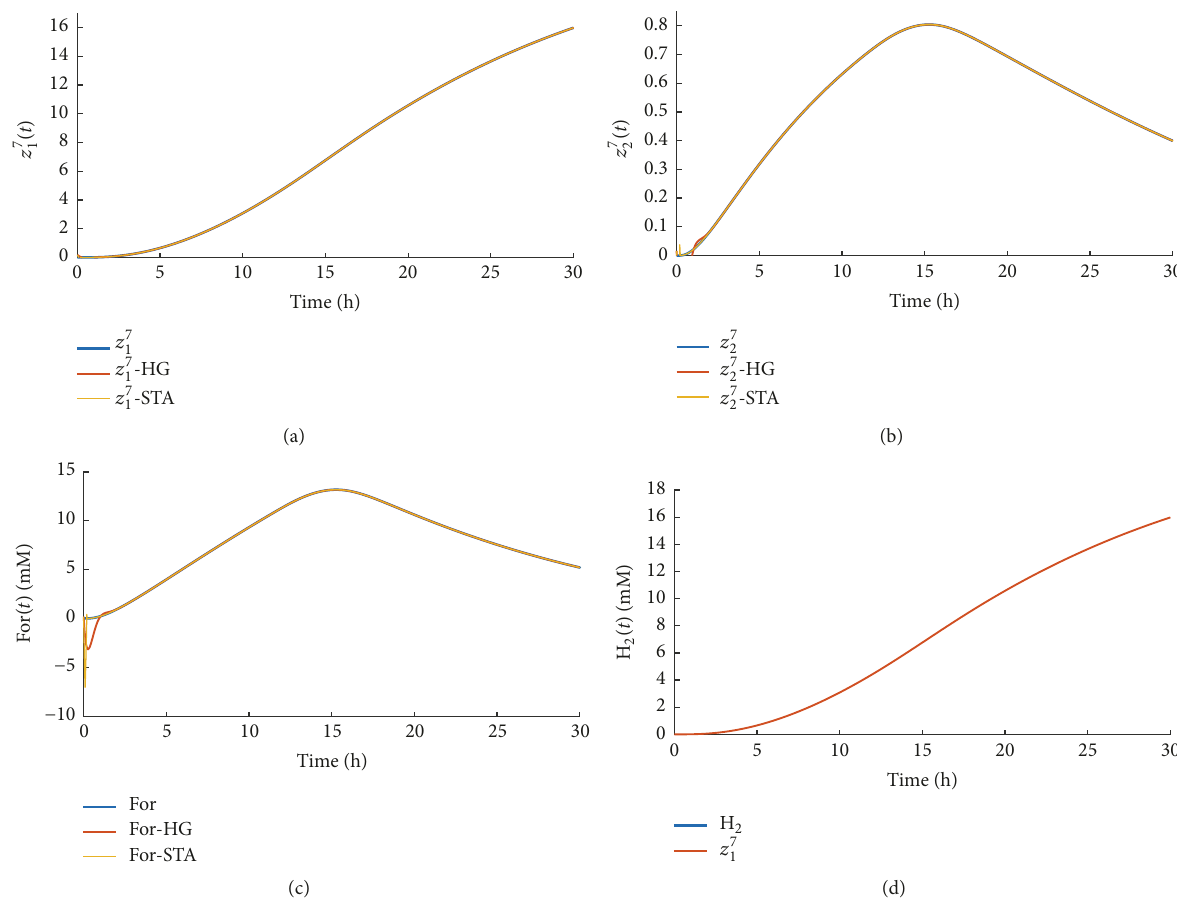
Figure 6: Simultaneous visualization for the states of the transformed coordinates in the seventh subsystem, the corresponding high-gain observer, and the STA-based estimator: (a) 𝑧 7 1 and (b) 𝑧 7 2 . (c) and (d) depict the variation of the concentrations for the compounds (c) For and (d) H 2 as well as their estimates produced by the inverse transformation applied to both the high-gain and the STA-based observer.